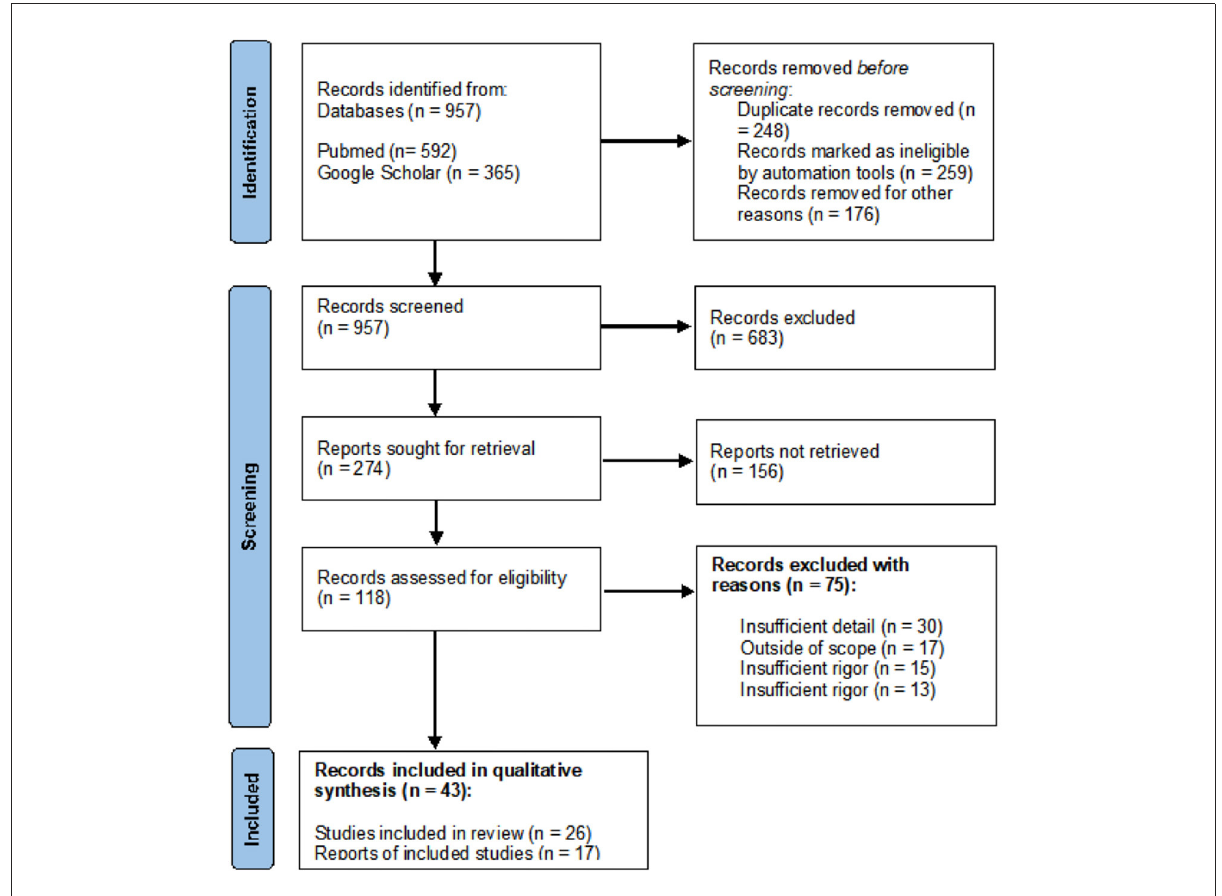
FIGURE1 PRISMA flowchart for study